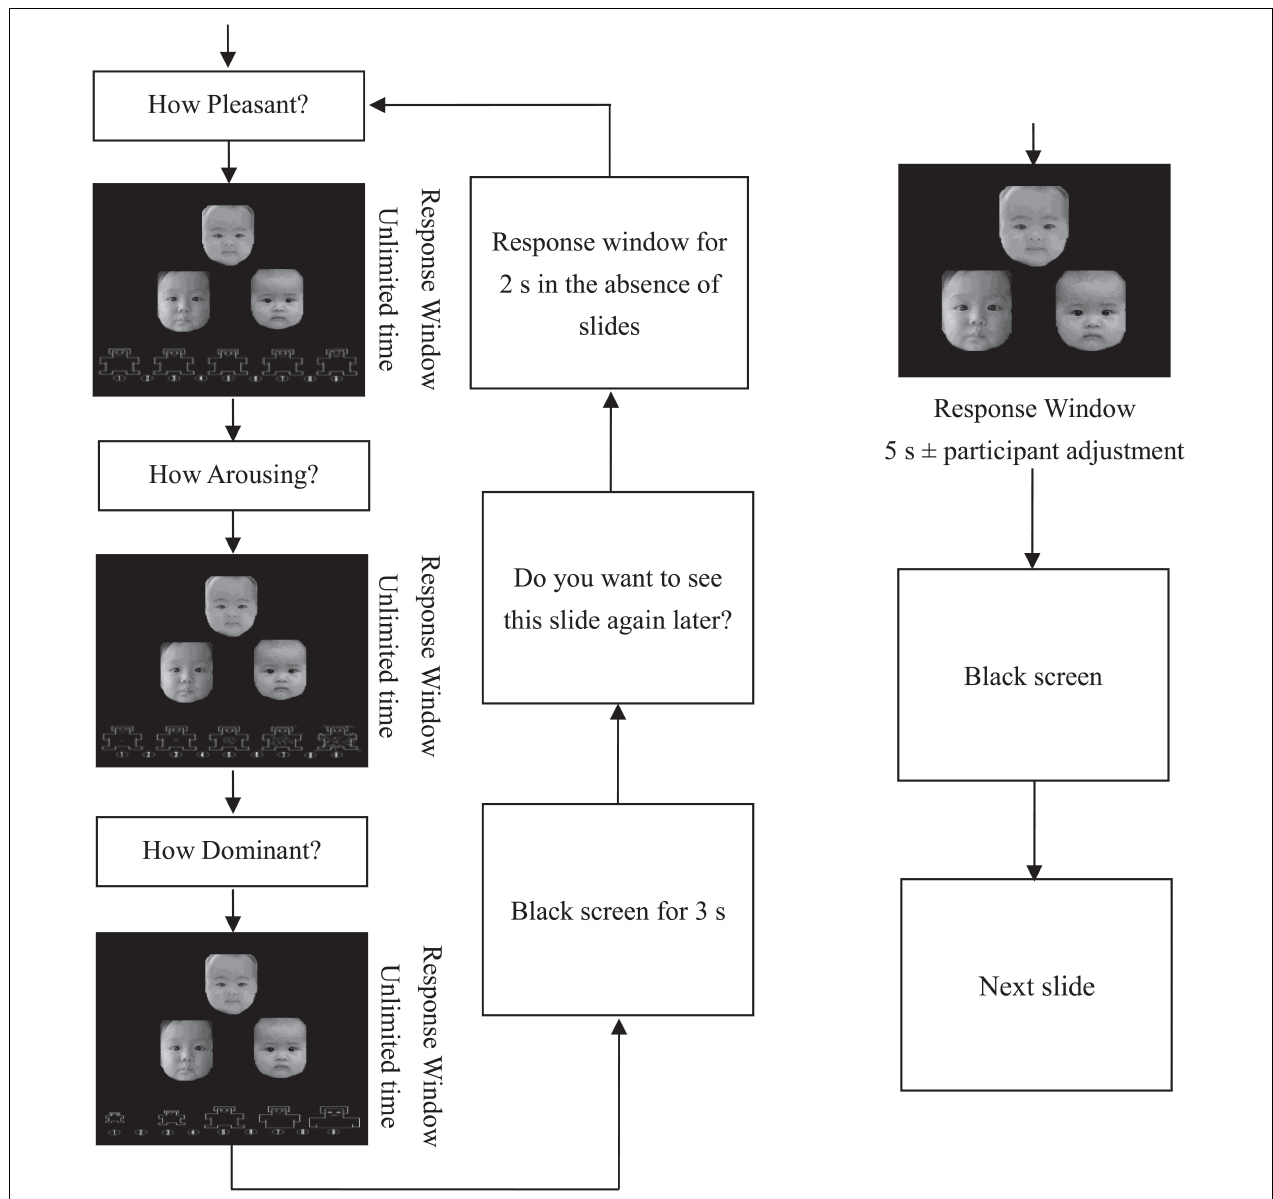
FIGURE 1 | Experimental procedure. The first block contains part A and part B, which are presented alternately. After the completion of the first block, part C commences. These infant faces were reprinted from the Chinese Infant Affective Face Picture System (CIAFS) under a CC BY license, with permission from GC, original copyright